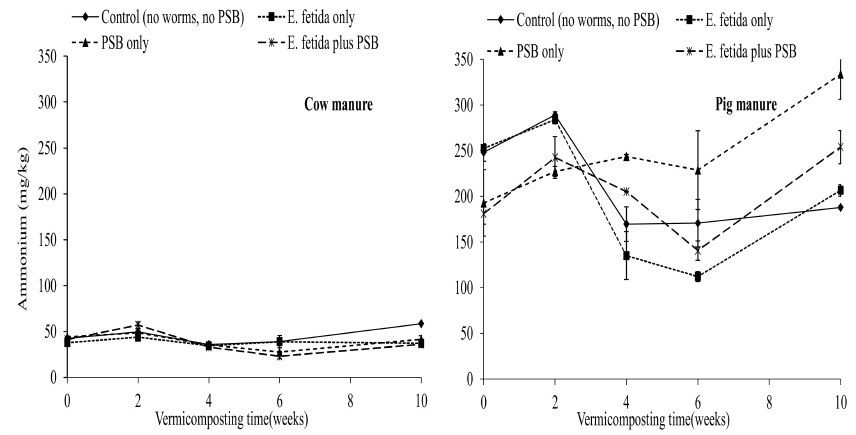
Figure 4. Changes in ammonium during vermicomposting of cow and pig manure amended with rock phosphate and P. fluorescence . Error bars indicate standard deviations.